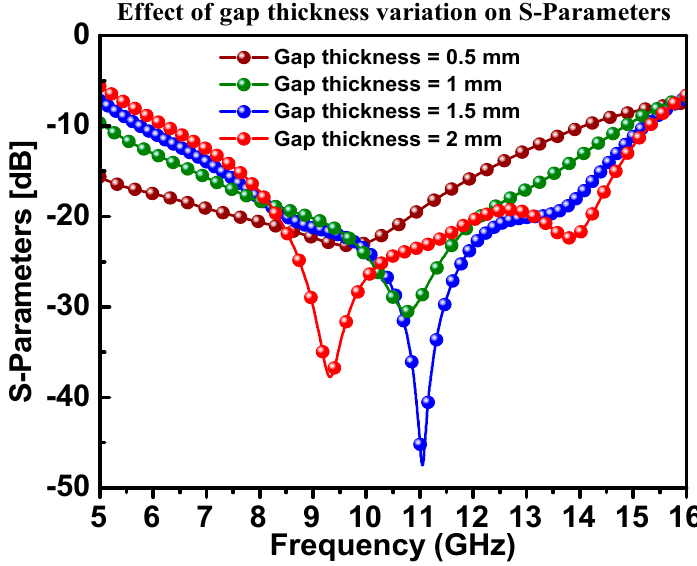
Figure 8. The effect of the antenna on the OSC gap variation on the S11 of the proposed CPW antenna.